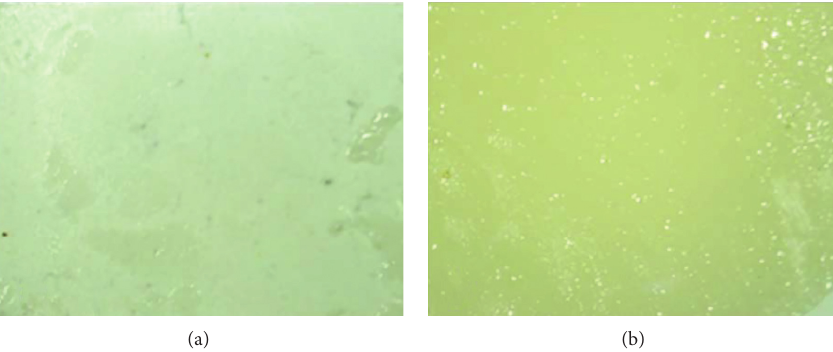
Figure 1: Stereomicroscopic images under 40x magnifications for bond failure. (a) Example of the adhesive failure where the debonded surface of the biodentine substrate (central area) is regular and free of any remnants of composite restoration (adherent) (it was a comparable finding for all examined surfaces of all tested groups). On the outside of the deboned surface, remnants of adhesive agents can be seen. (b) The composite debonded surface (adherent) is regular and free of any remnants of Biodentine